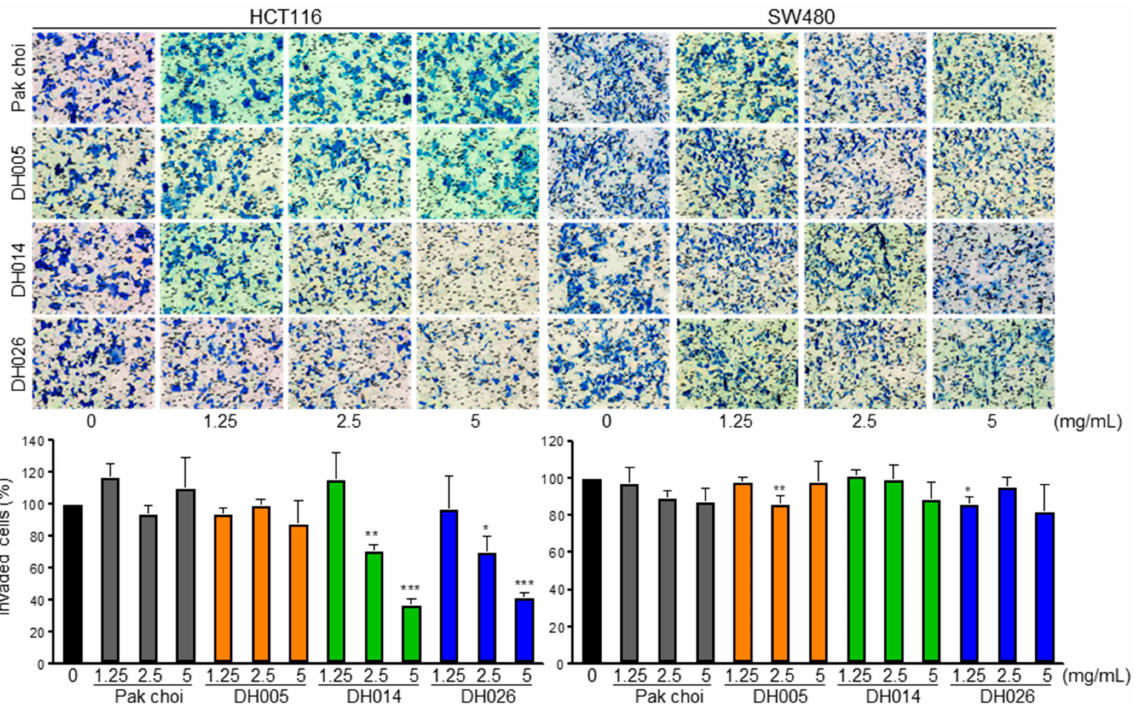
Figure 2. Anti-invasion effects of high glucosinolate (GSL) (HGSL) doubled haploid (DH) lines (DHLs) (DH005, DH014, and DH026) in human colorectal cancer (CRC) cells. HCT116 and SW480 cells in the serum-free media were seeded onto the upper side of Boyden chambers, treated with either HGSL DH or pak choi extract, and 24 h later the membranes were fixed, stained, and photographed. Invaded cells were counted in three randomly chosen fields of each membrane. Data in the bar graphs represent the mean ± SEM of three independent experiments in duplicate or triplicate (*, p < 0.05; **, p < 0.01 and ***, p < 0.001 versus